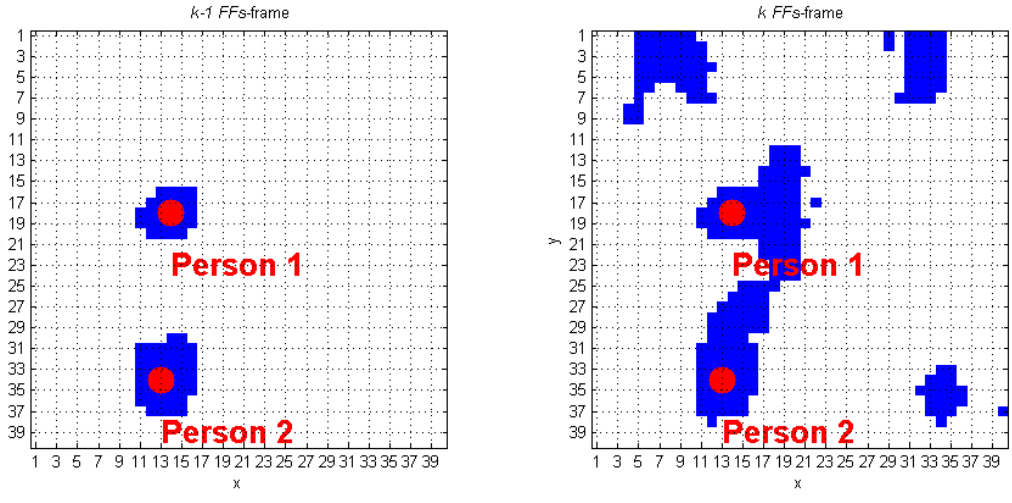
Figure 8. Handling the fusion of two human subjects into a single